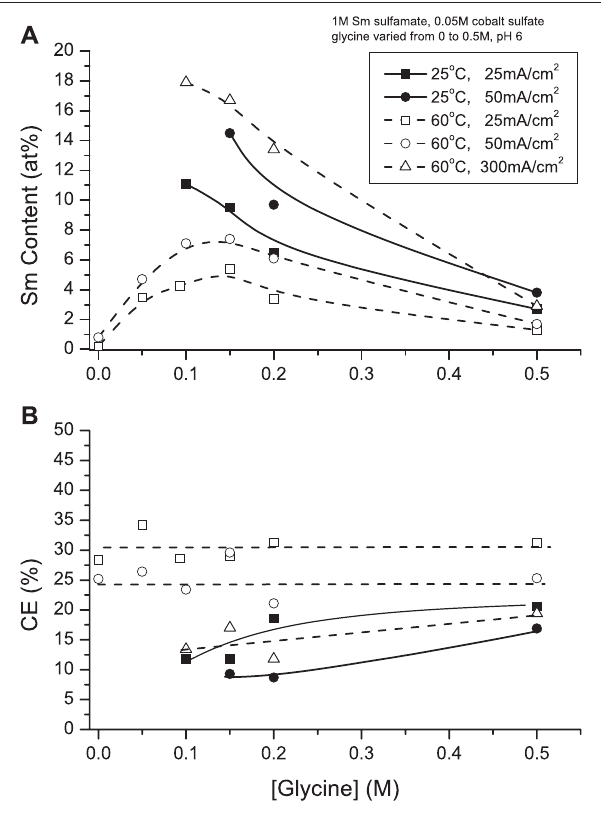
FIGURE 7 | Effect of solution pH on (A) Sm deposit content and (B) current ef fi ciency different temperature (25 and 60 ° C) and various CDs.